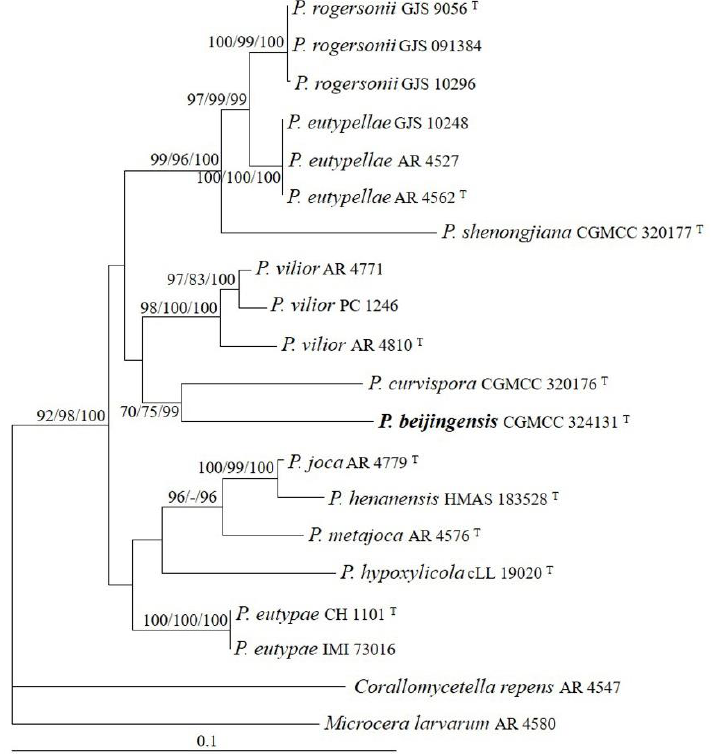
Figure 2. The maximum likelihood tree inferred from combined ITS, LSU, and tub2 sequences of representative species of Pseudocosmospora . MLBP ( left ) and MPBP ( middle ) values greater than 70% and BIPP ( right ) values greater than 90% were shown at the